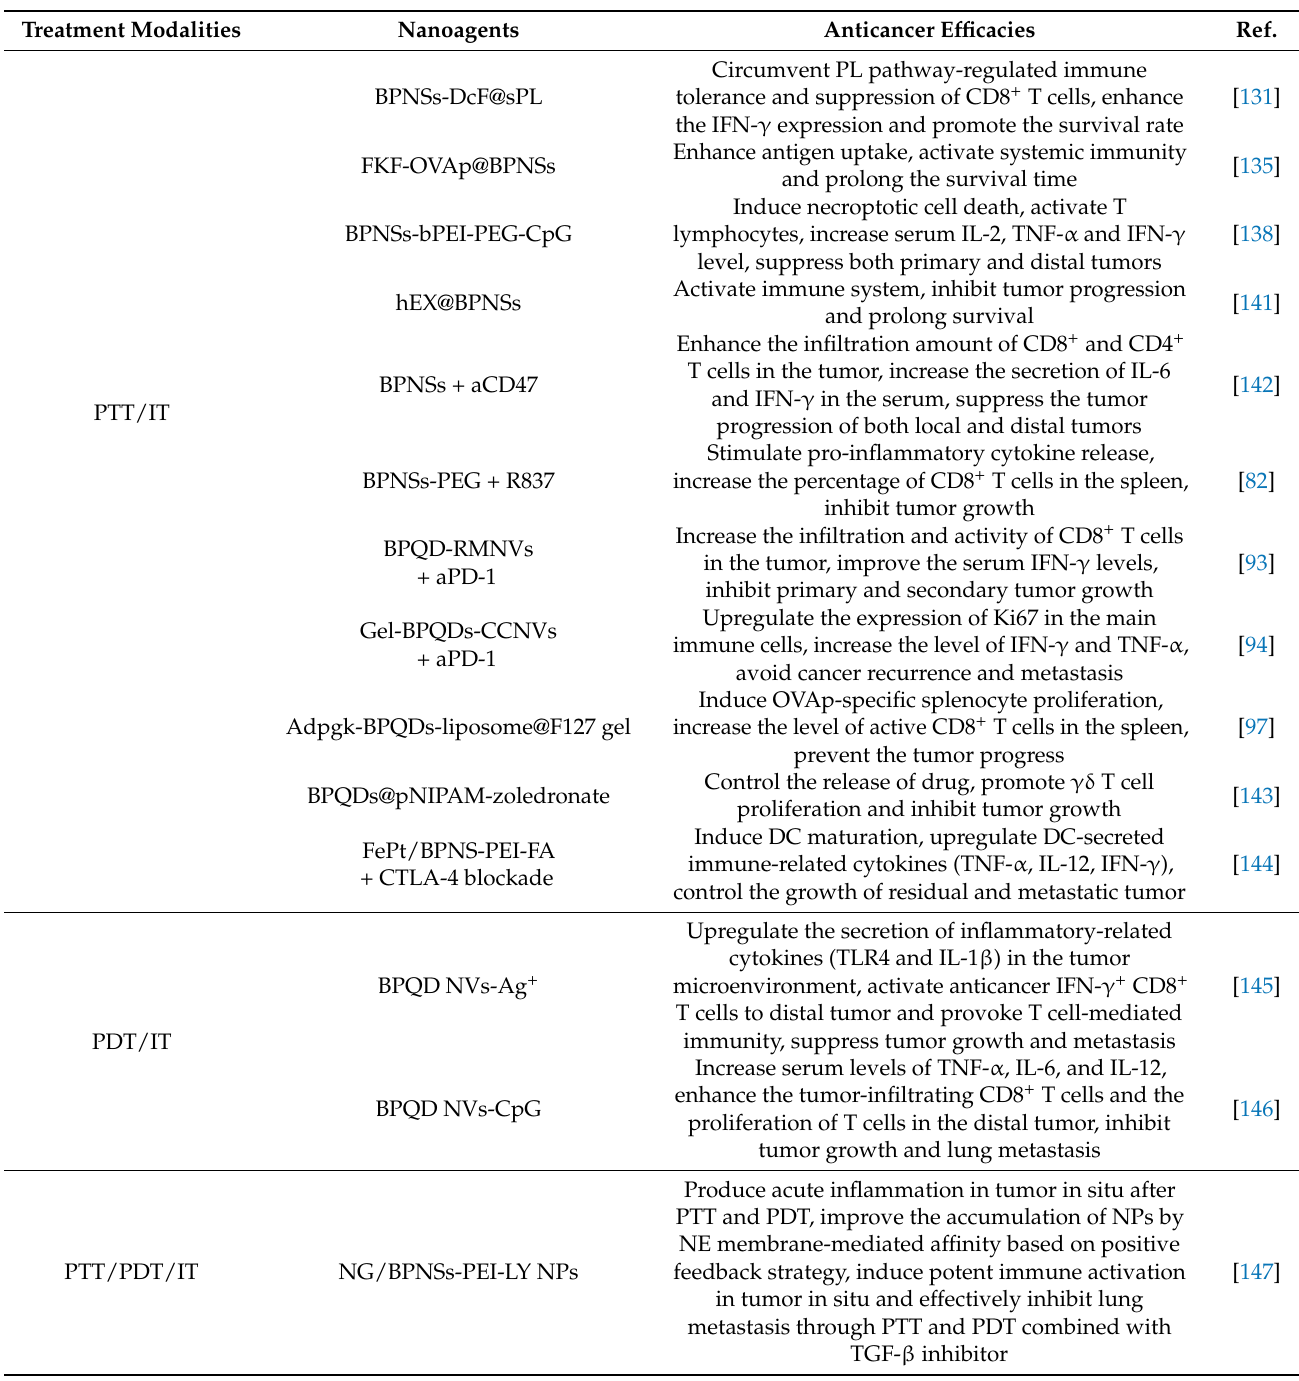
Table 4. The summarized applications of BP nanomaterials for synergistic